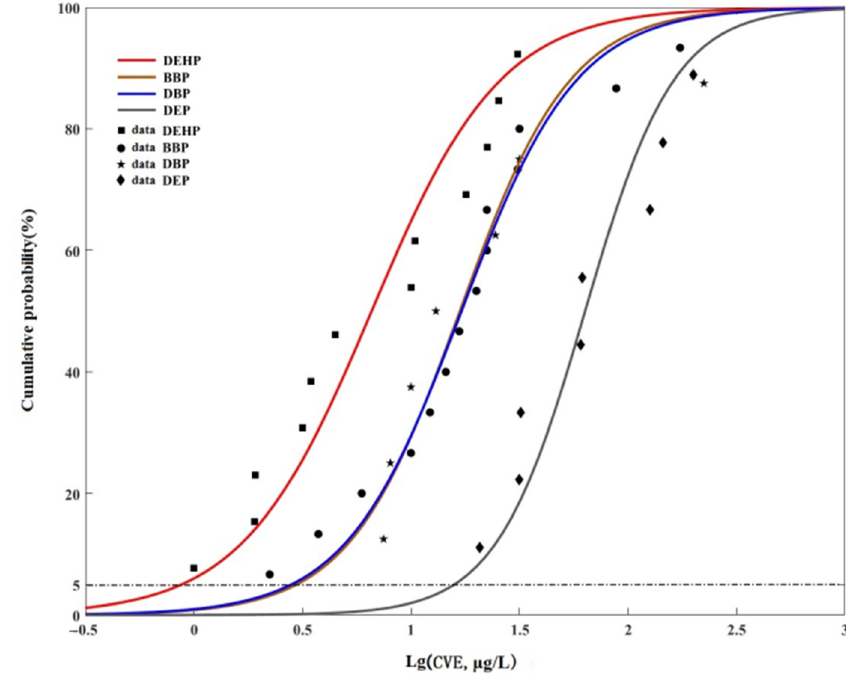
Figure 2. Species sensitivity distribution curves of PAEs. Table 1. Parameters of SSDs for four PAEs (exclude DIBP).